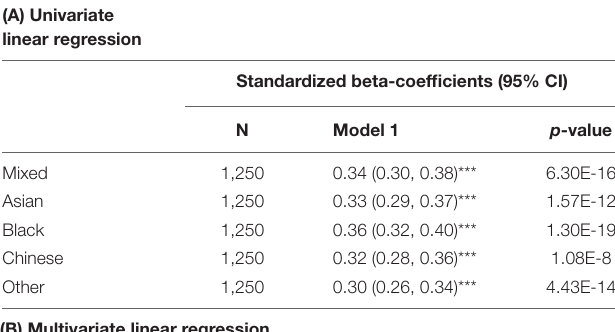
TABLE 4 | Associations between average DSC and racial group. (A) Univariate linear regression